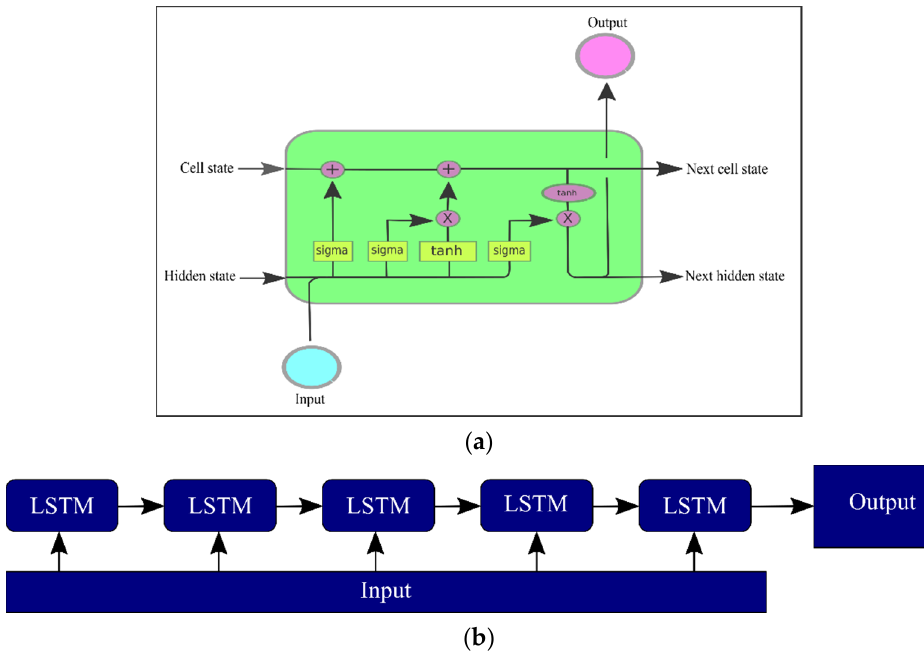
Figure 4. Deep long short-term memory network training architecture. ( a ) Description of a structure of a single Long Short-Term Memory (LSTM) cell; ( b ) Basic deep LSTM structure typically constructed of multiple LSTM cells.